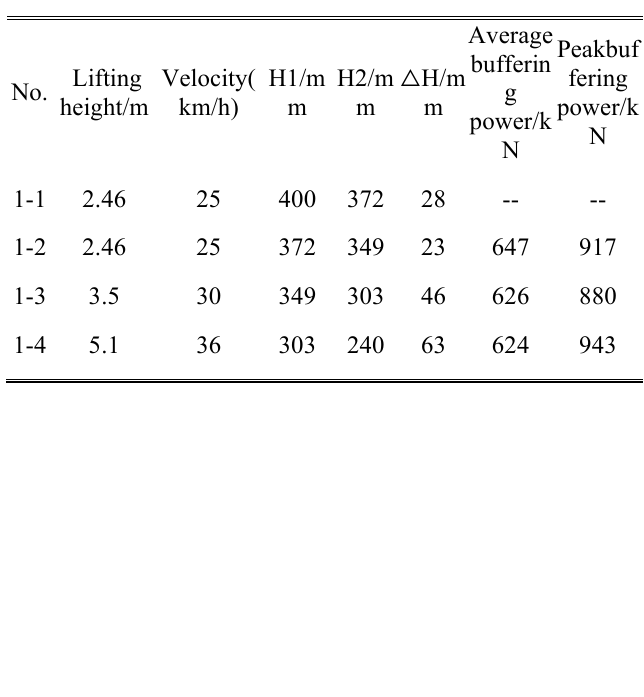
The dropping hammer is lifted at different heights to obtain different impact velocity and impact energy. In this dropping hammer test, a total of 3 impacts are carried out on a test piece. The parameters and results of each impact test are shown in table 3. The obtained test curve is shown in figure 8. Figure 6. Dropping hammer test specimen size and material Table 3. Statistical analysis of test